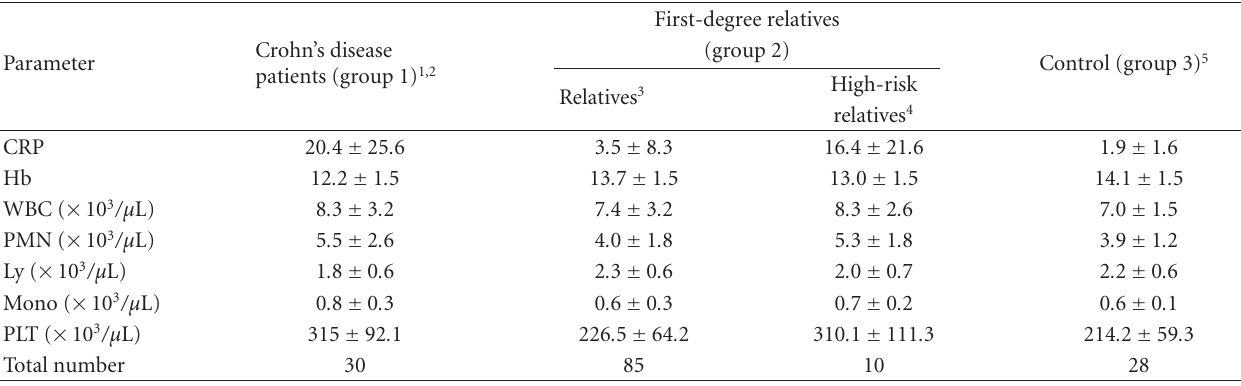
Table 2: Hematological parameters of CD, FDR, and